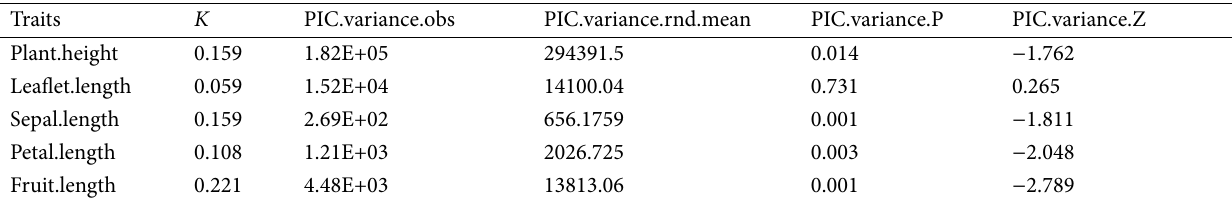
Table 1 K statistics of phylogenetic signals for continuous traits. Traits K PIC.variance.obs PIC.variance.rnd.mean PIC.variance.P PIC.variance.Z